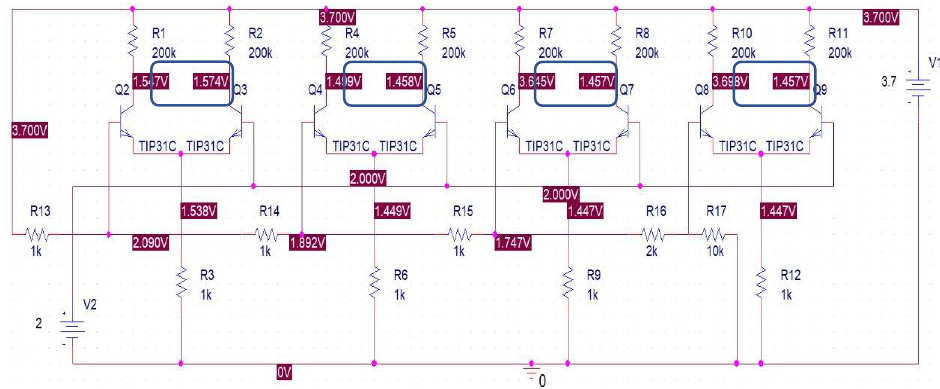
Figure 16. Receiver Circuit Simulation for 2 V input.